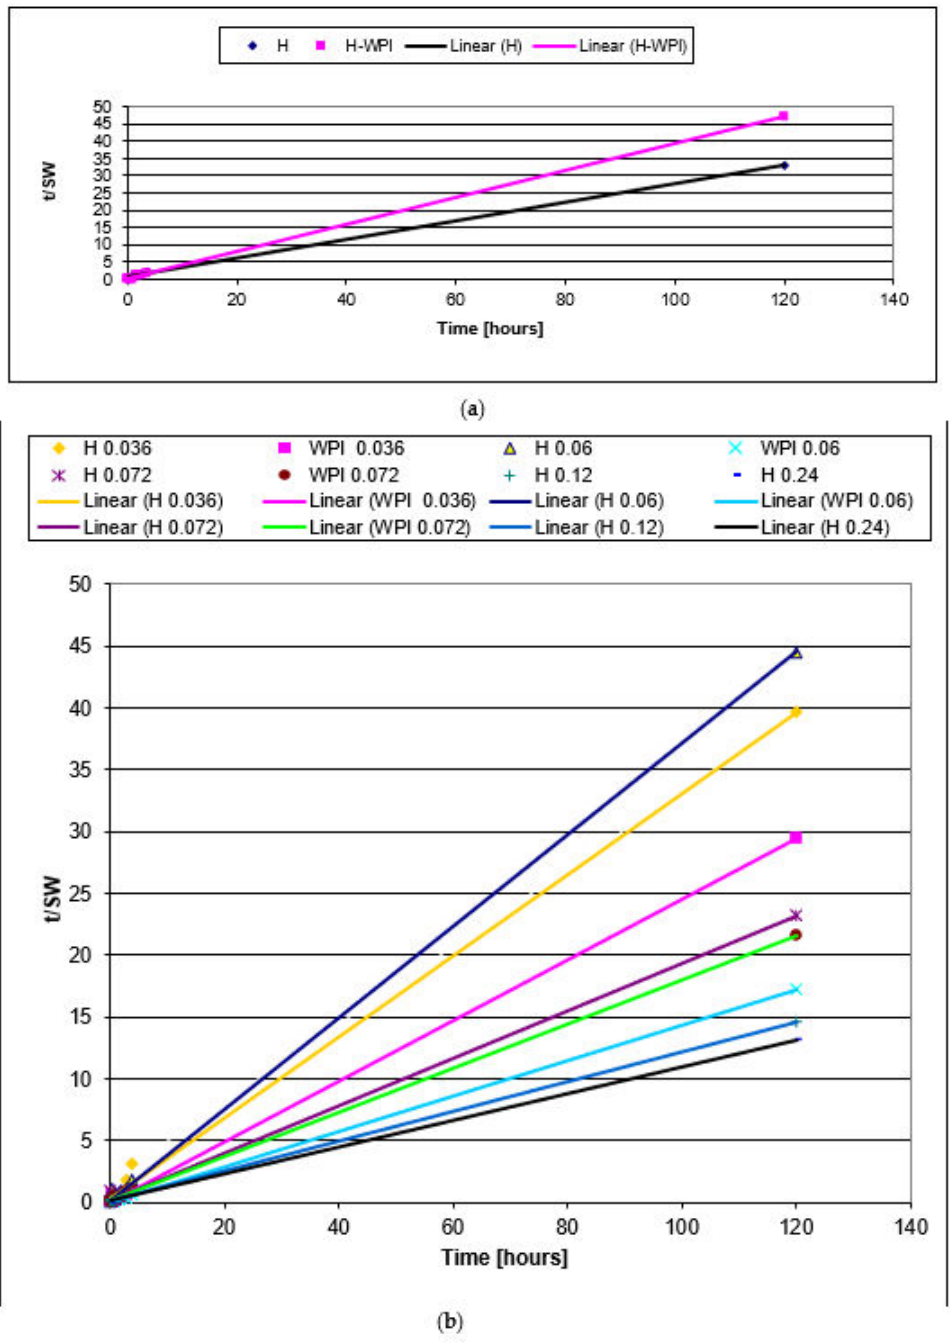
Figure 6. The plot of t/SW against t for samples H and WPI ( a ), and samples containing copper ( b